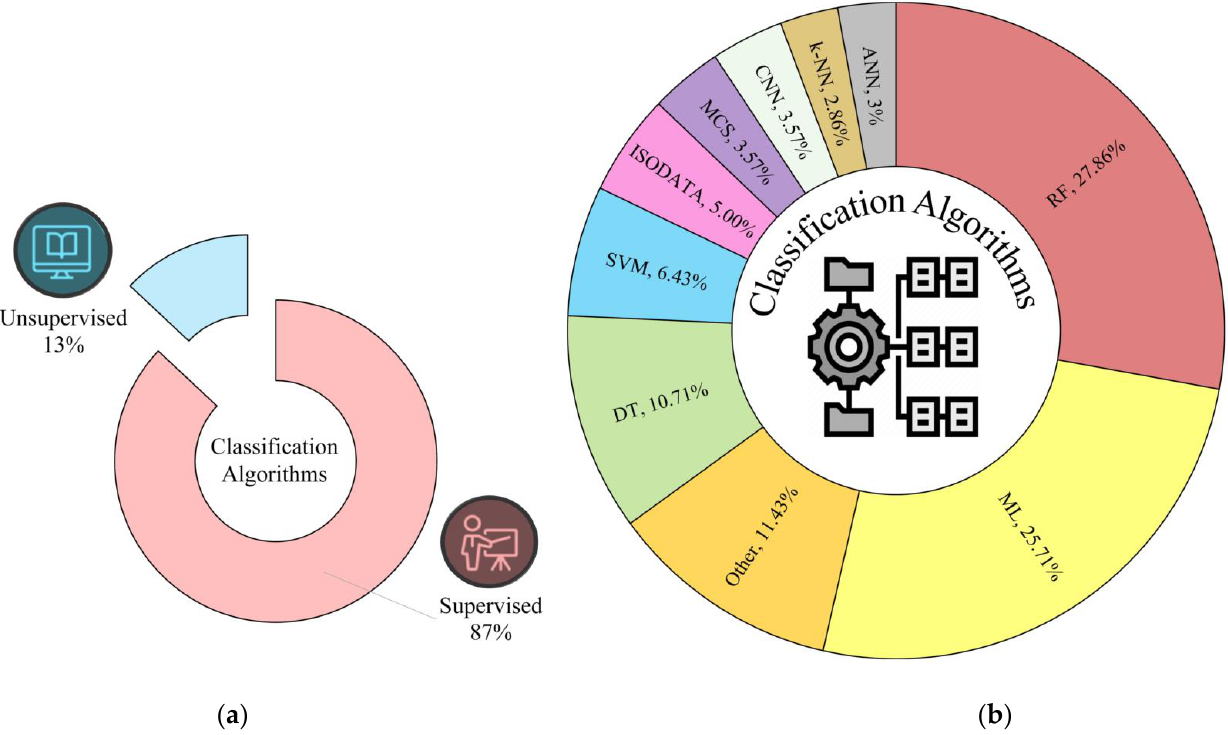
Figure 11. Percentage of the used machine learning ( a ) supervised and unsupervised classification approaches and ( b ) classifiers in wetland classification studies in Canada.